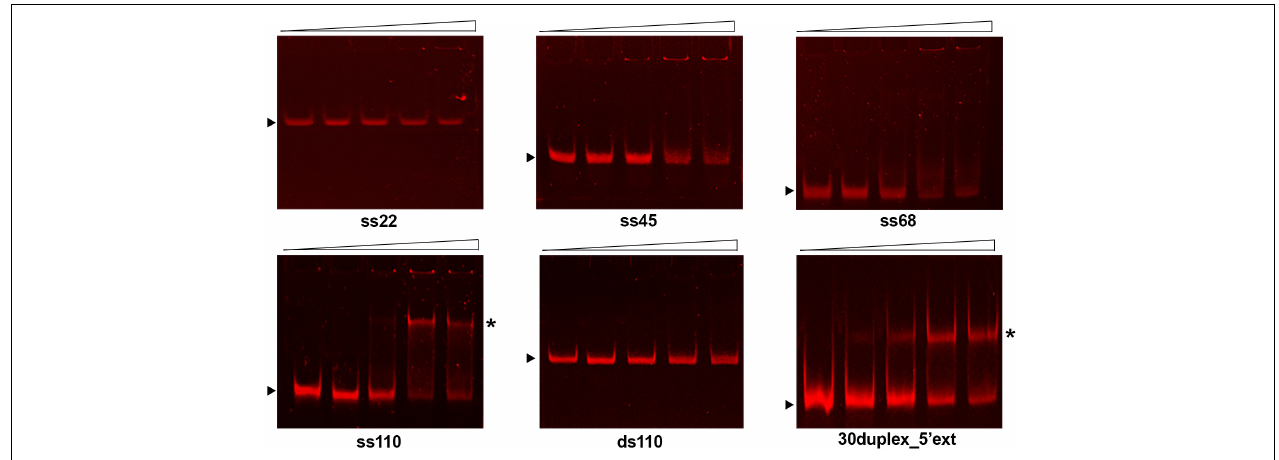
FIGURE 3 | Binding of the GP46 F 13 protein to DNA substrates. Rising concentrations of GP46 F 13 (0.1, 0.25, 0.5, and 0.75 µ M) were incubated with 1 nM of ssDNA (ss22, ss45, ss68, ss110), dsDNA (110ds) or forked substrate with elongated 5 (cid:48) tail (30duplex_5 (cid:48) ext) for 30 min at 30 ◦ C in binding buffer (20 mM Tris–HCl pH 8, 50 mM NaCl, 1 mM DTT, 1 mM EDTA, 0.1 mg/ml of BSA, 2.5% glycerol) in 20 µ l reaction volume. Reaction samples were analyzed on 7% native polyacrylamide gels. Nucleoprotein complexes are indicated by asterisk and unbound DNA substrates by black